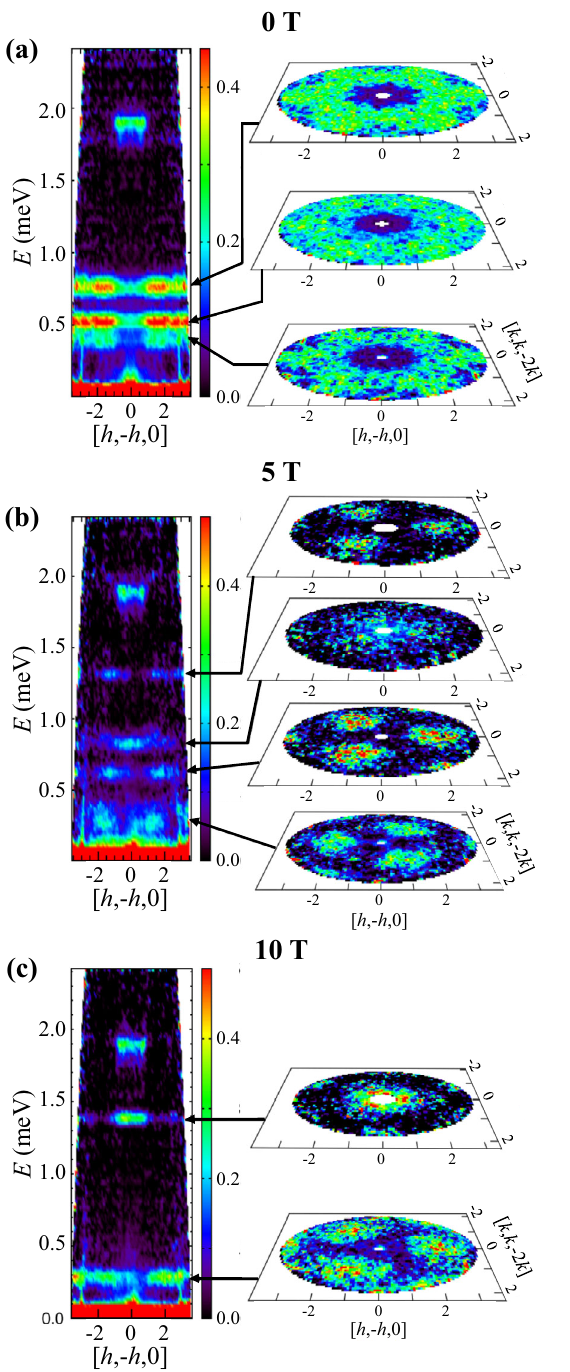
Fig. 3 Inelastic neutron scattering results. Inelastic neutron scattering from a single-crystal sample of Ba 3 Yb 2 Zn 5 O 11 measured at T = 70 mK using the Disk Chopper Spectrometer (DCS) for a series of fi elds H ∥ [111] a 0 T b 5 T, and c 10 T. For each fi eld, the left panel shows the dynamical structure factor as a function of energy transfer and momentum along [ h , − h , 0] direction. An integration over the full K range in the [ k , k , − 2 k ] direction was performed, i.e., covering the Q range from − 2 to 2 along that direction. On the right, constant energy intensity maps in the [ h + k , − h + k , − 2 k ] plane are shown for selected dispersionless bands which are integrated along energy with an energy width speci fi ed to fully capture each band for each magnetic fi